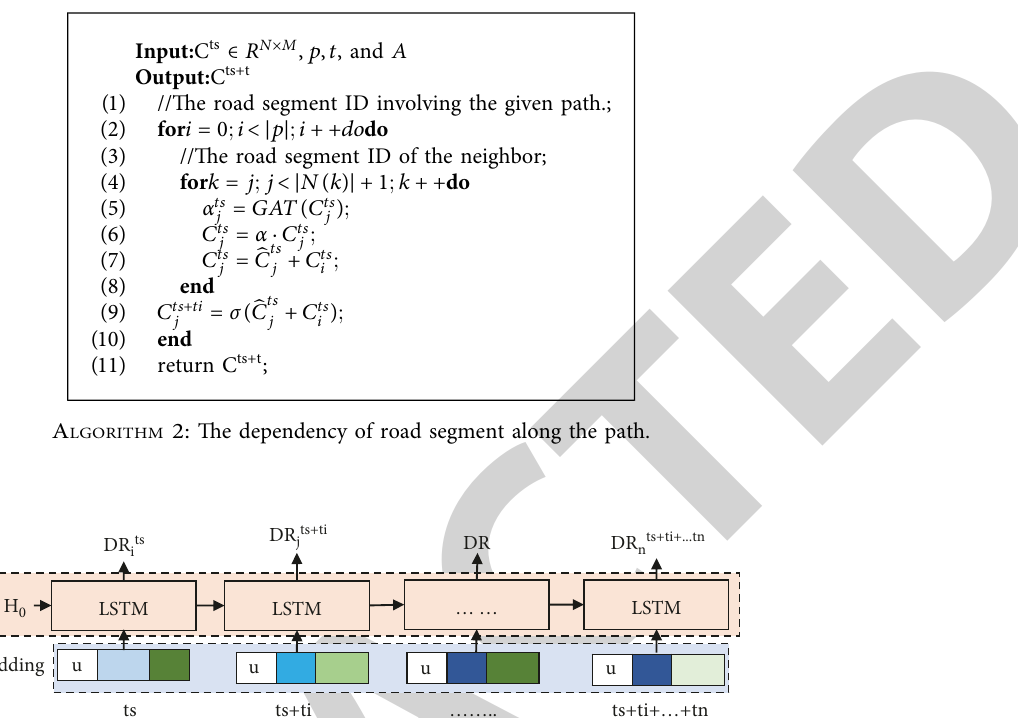
Figure 7: Dynamic meta-learning component for learning the driving habit for the assigned driver u